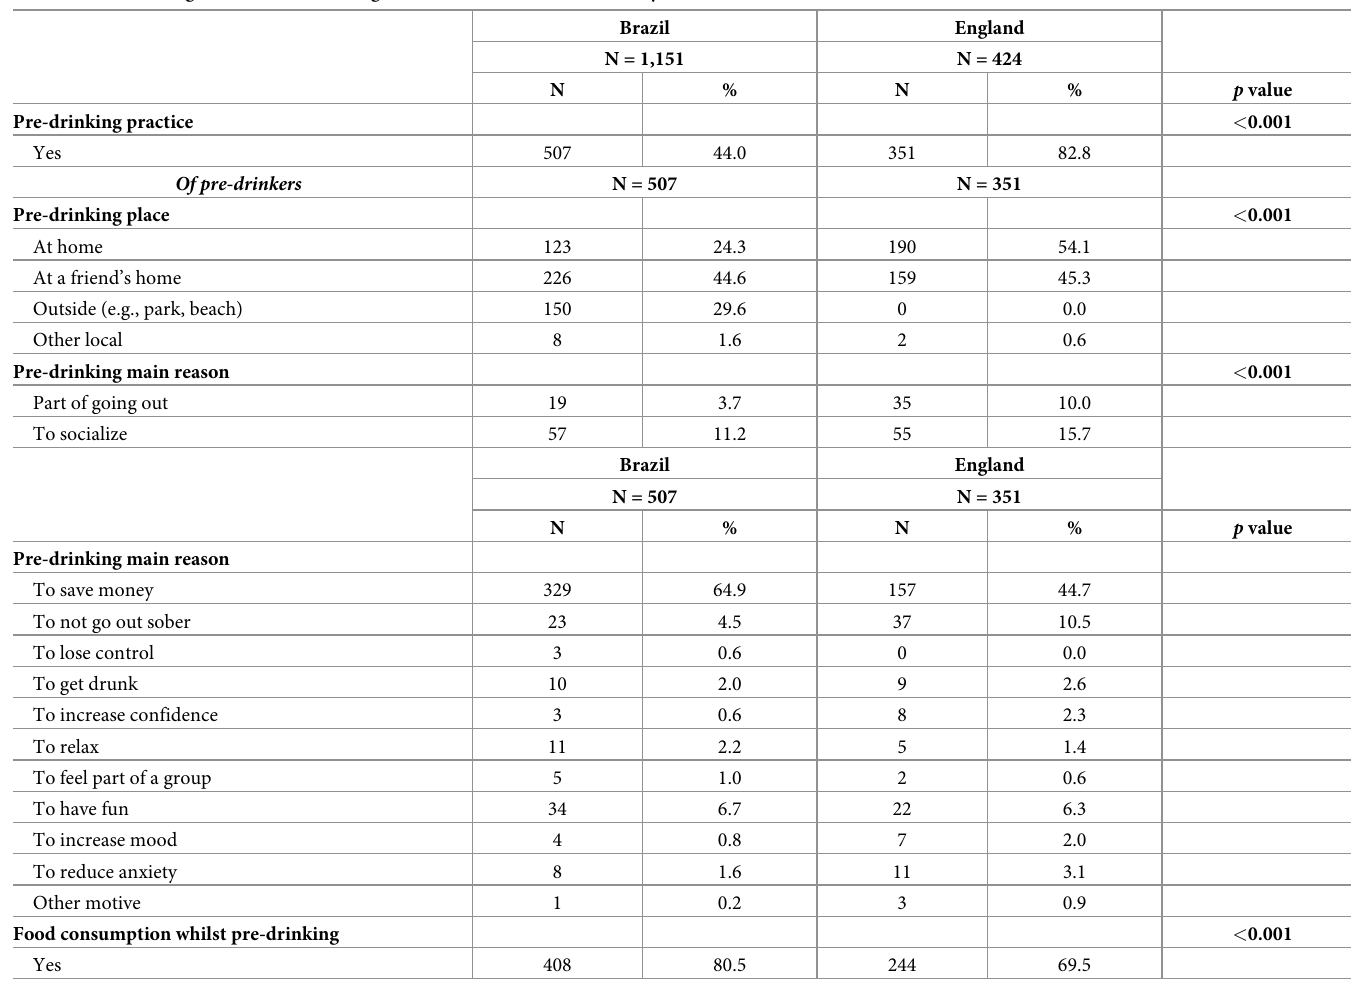
Table 3. Pre-drinking characteristics amongst Brazilian and British university